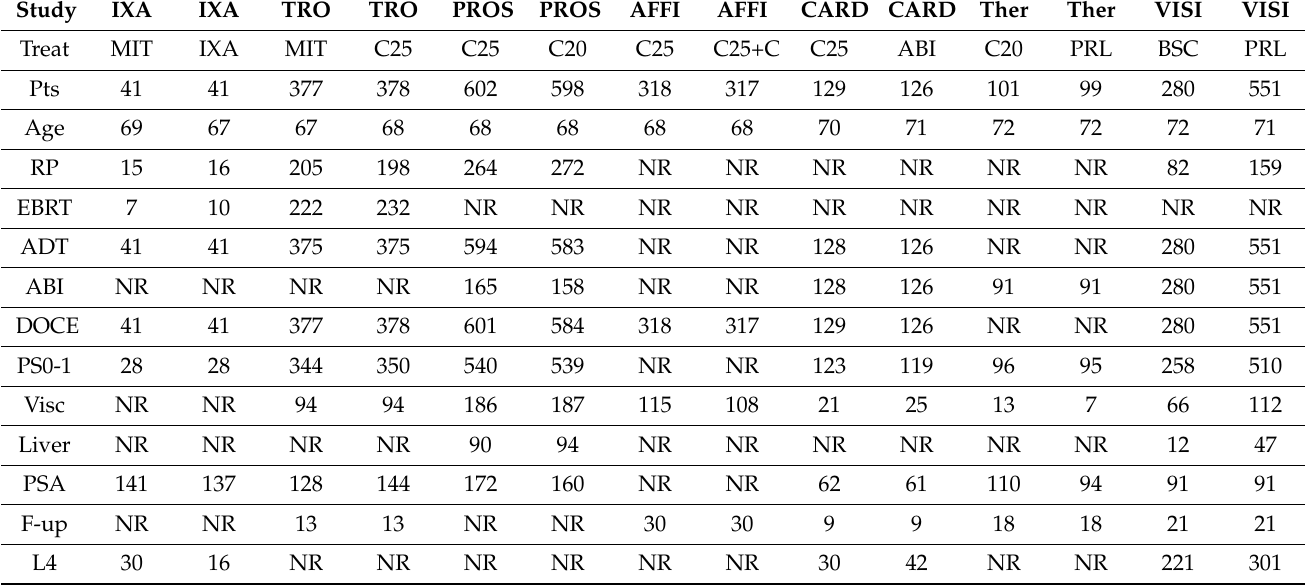
Table 1. Clinical